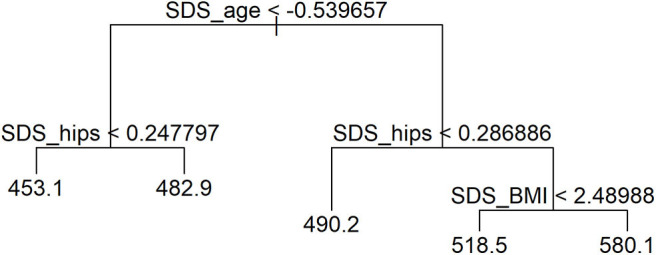
Regression tree model analyzing interactions of independent variables.